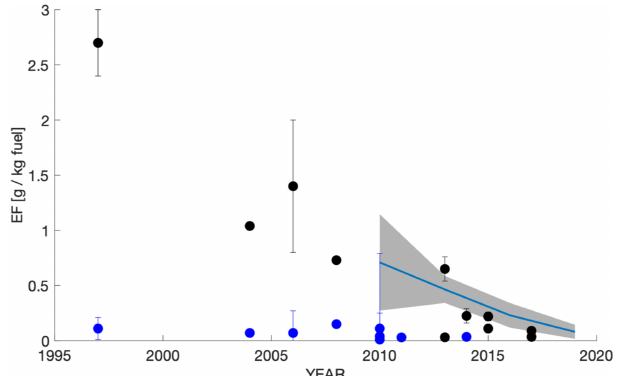
Figure 1. On-road measurements of emission factors from other studies. HDV (black) emission factors converge on LDV (blue) emission factors. Some studies do not give error bars. Gray patches and blue trend lines indicate findings from this study for the two highway sites (Redwood City, RWC, and San Rafael, SR) avail- able during all time periods. The blue trend line shows the error- weighted mean of emission factors at these two sites during each time period. Gray patches indicate the estimated uncertainty in the error-weighted